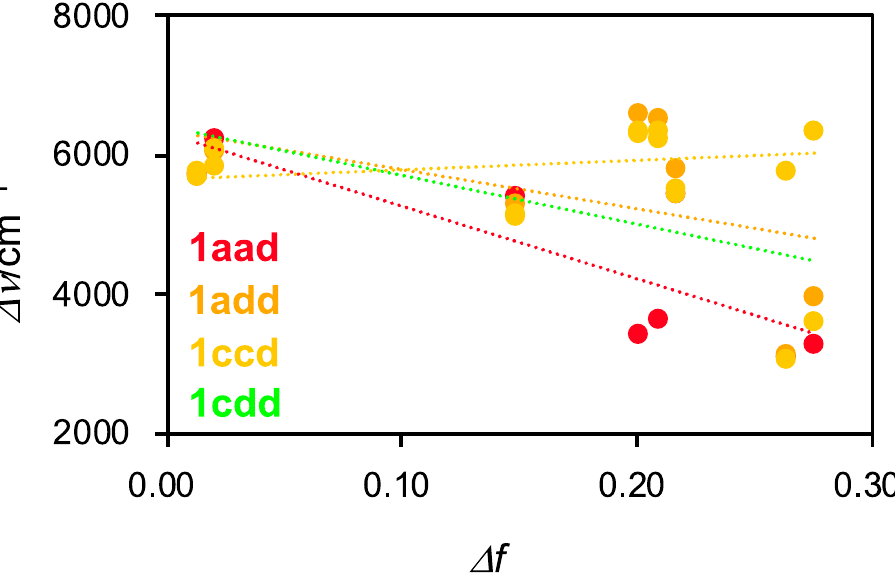
Figure 7. Lippert ‐ Mataga plots for 1aad , 1add , 1ccd , and 1cdd in various solvents. Δν (Stokes shift) = ν abs − ν fl , ∆ f (Orientation polarizability) = ( ε r − 1/2 ε r + 1) – (n 2 − 1/2n 2 + = ν abs − ν fl , Δ f (Orientation polarizability) = ( ε r − 1/2 ε r + 1) – (n 2 − 1/2n 2 + 1).